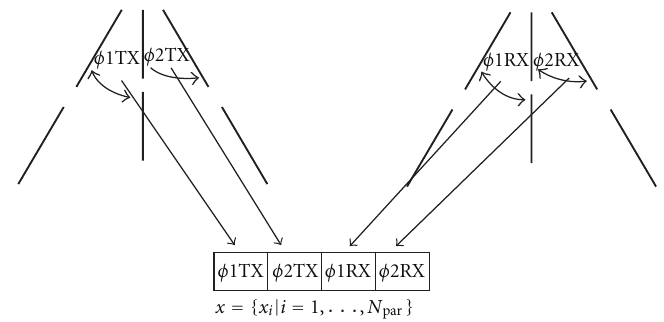
Figure 13: Coding scheme for GA.